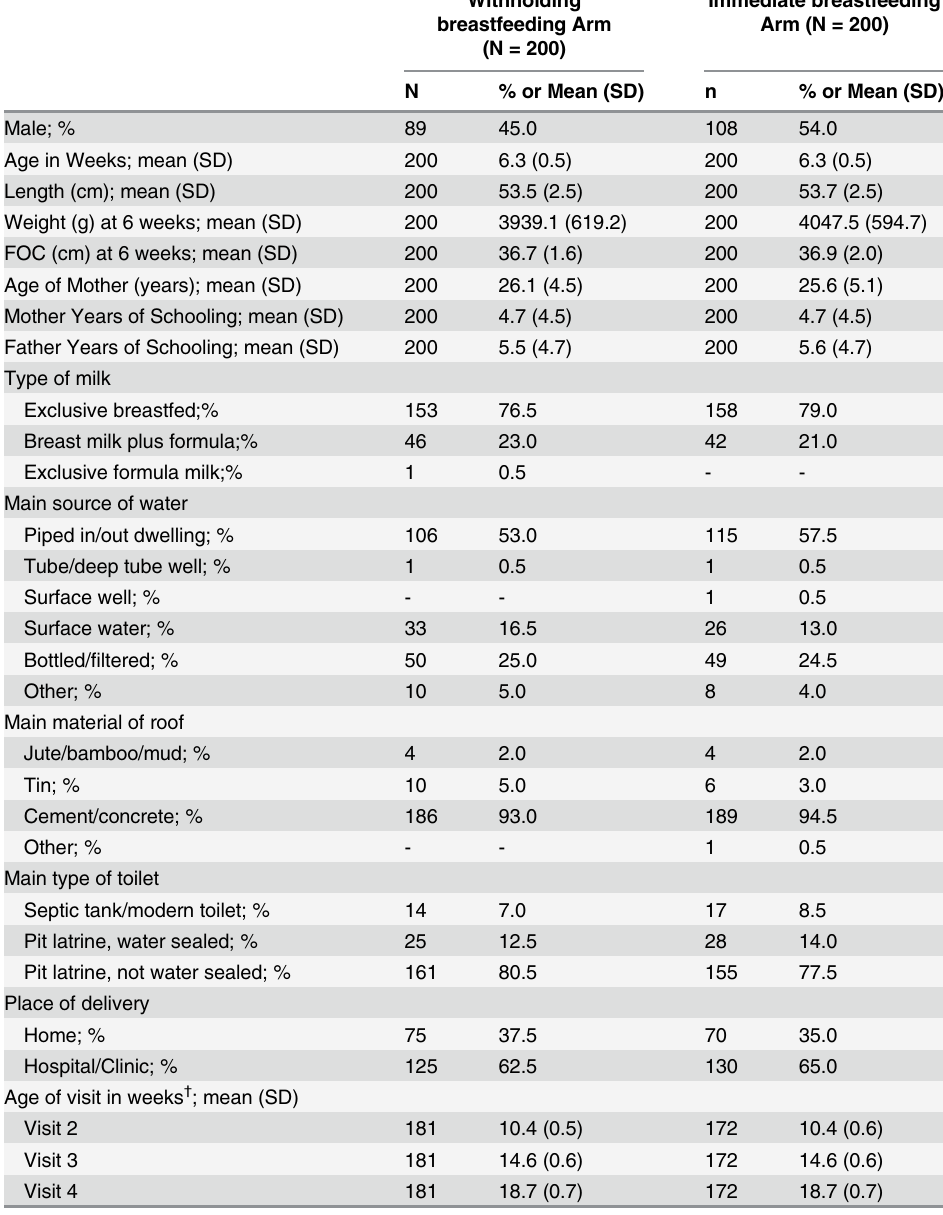
Table 2. Baseline Characteristics and Age at Study